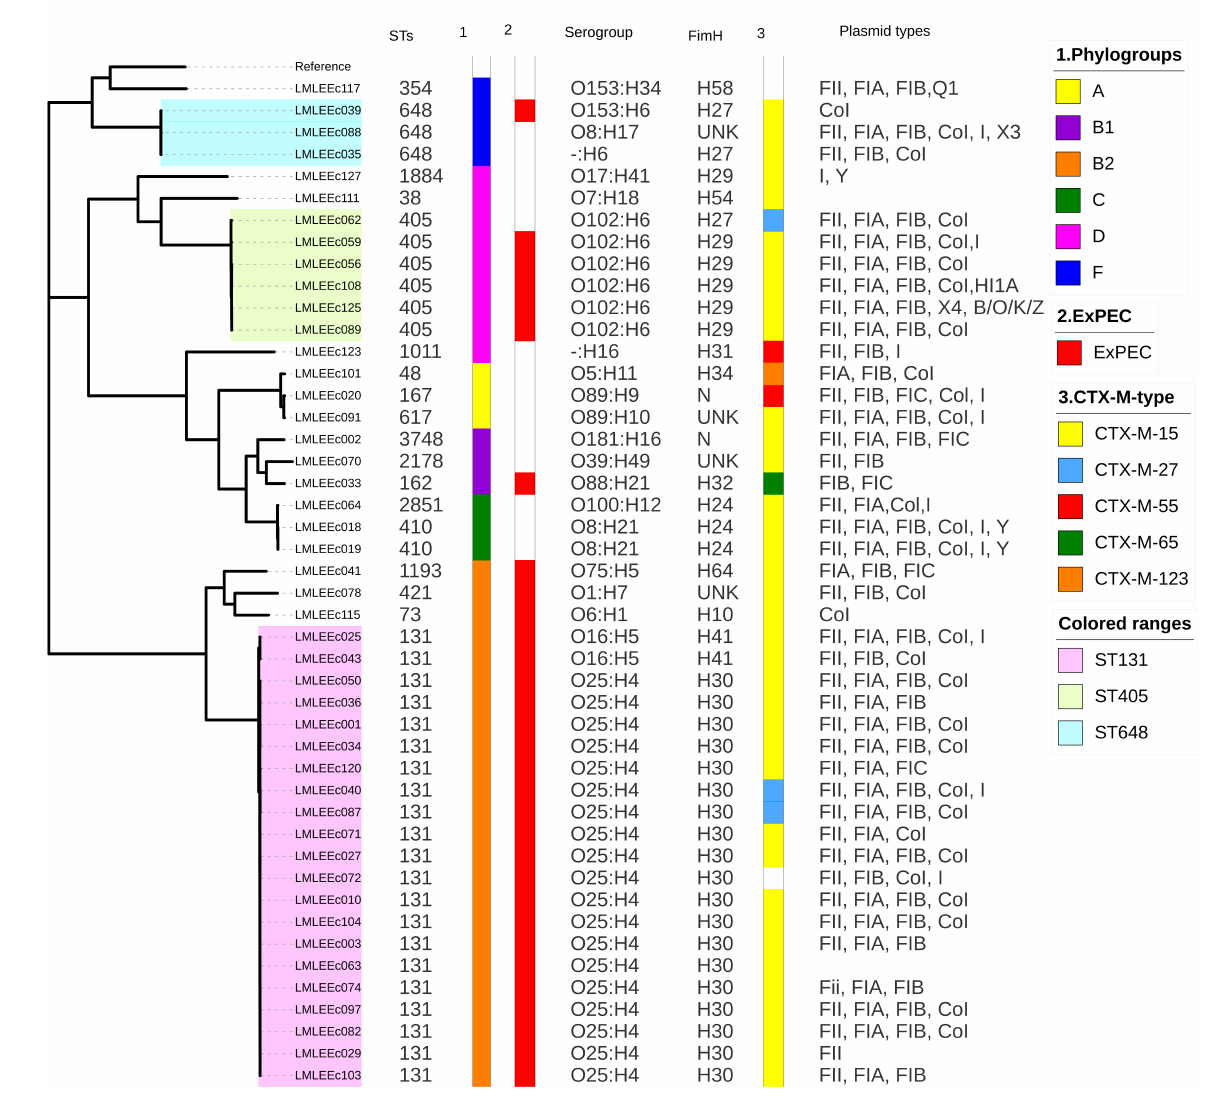
FIGURE 1 | Core-genome SNP-based phylogenetic tree representing the population structure and comparison of genetic traits observed in 46 ESBL E. coli isolates. Sequence types, phylogroups, ExPEC status, serogroups, fimH types, CT-X-M types, and plasmid replicon types are shown next to the tree. aminoglycoside genes, only two, aac(3)-IIa (14/13) and aac(6 (cid:48) )- Ib-cr (21/14), were strongly associated with gentamicin resistance ( p < 0.001). None of the aminoglycoside genes was associated harbored aac(3)-IId , aadA1 , and aph(3 (cid:48) )-Ia ; other genes of this class included aac(6 (cid:48) )-Ib (one isolate), aadA2b (one isolate),